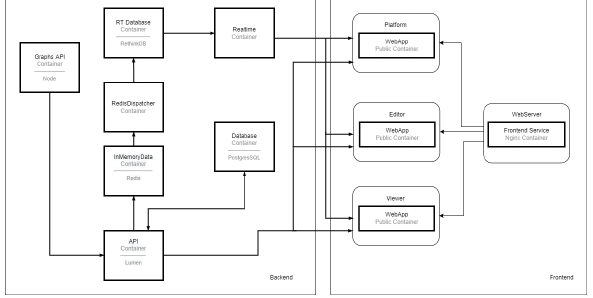
Figure 1. Solution